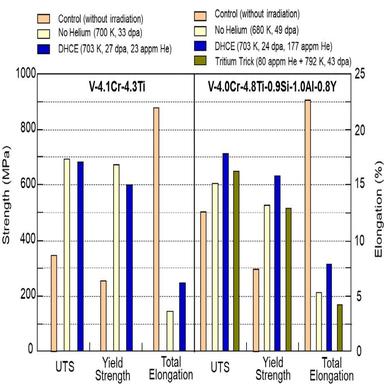
Tensile properties of V-4.1Cr-4.3Ti alloy and V-4.0Cr-4.8Ti-0.9Si-1.0Al-0.8Y alloy irradiated in FFTF/MOTA without and with dynamic helium charging (DHCE). V-4.0Cr-4.8Ti-0.9Si-1.0Al-0.8Y alloy includes Tritium Trick experiment data, in which helium was charged before irradiation. The test temperatures were 693∼698 K for V-4.1Cr-4.3Ti alloy, and 723 K for the control and 673 K for the others for V-4.0Cr-4.8Ti-0.9Si-1.0Al-0.8Y alloy.